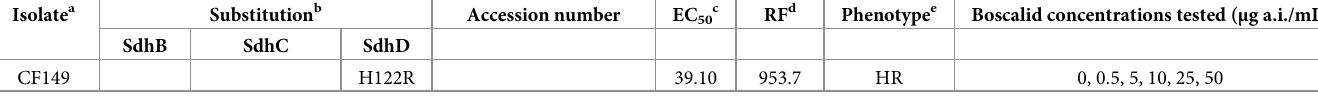
leaves. b Substitution identified via high resolution melt assay and confirmed by sequencing. c EC 50 = estimated boscalid concentration ( μ g/a.i./mL) to reduce radial growth by 50% of the non-amended controls. Calculated using logistic regression of the relative growth against log 10 of the boscalid concentration. d